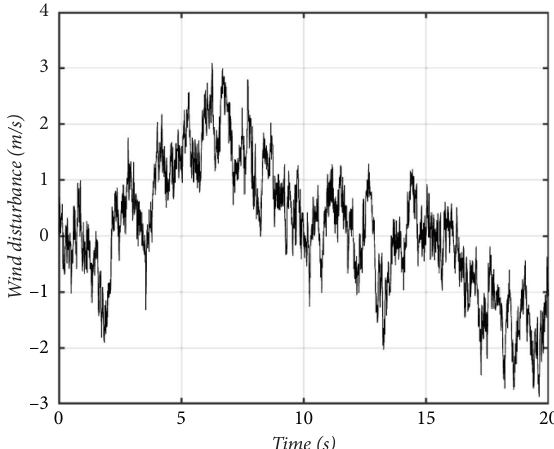
Figure 4: Te wind velocity generated using the Davenport